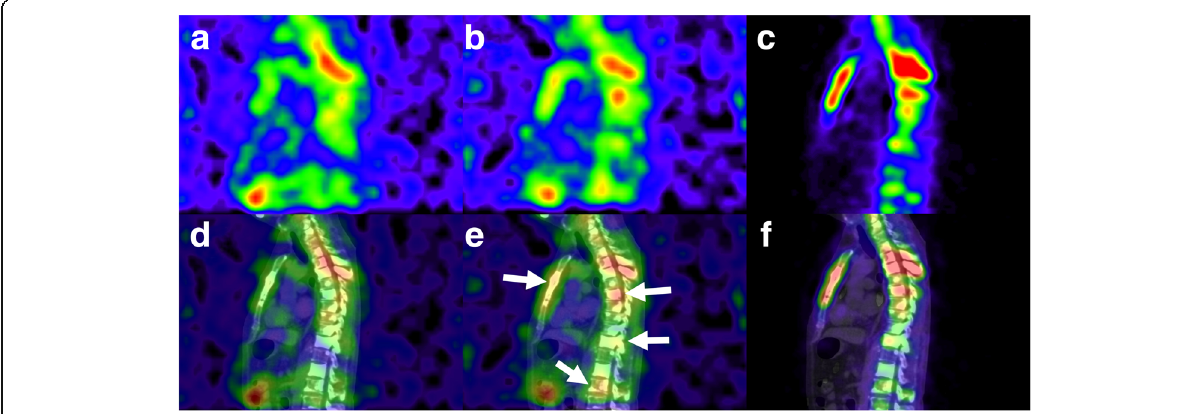
Fig. 7 Comparison of Ra-223 SPECT with the MEGP ( a ) or HEGP collimators ( b ) and Tc-99m HMDP SPECT ( c ) in a patient with prostate cancer with bone metastases (patient no. 3). The corresponding SPECT/CT fused images are shown in d , e , and f . It should be noted that Ra-223 SPECT depicted more lesions with the HEGP than with the MEGP collimator (arrows), even though the SPECT scan with HEGP was performed prior to the scan with MEGP. HMDP hydroxymethylene diphosphonate, MEGP medium-energy general purpose, HEGP high-energy general purpose, HMDP hydroxymethylene